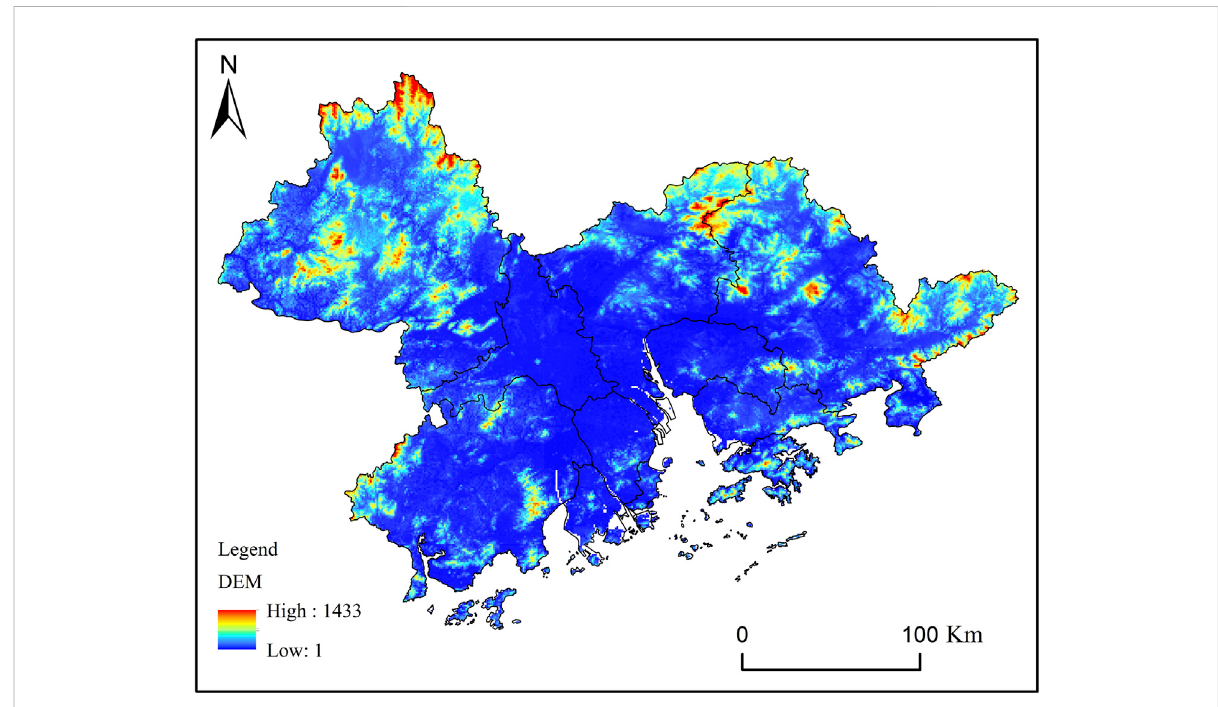
FIGURE 11 Digital elevation model (DEM) of the Guangdong – Hong Kong – Macau Greater Bay